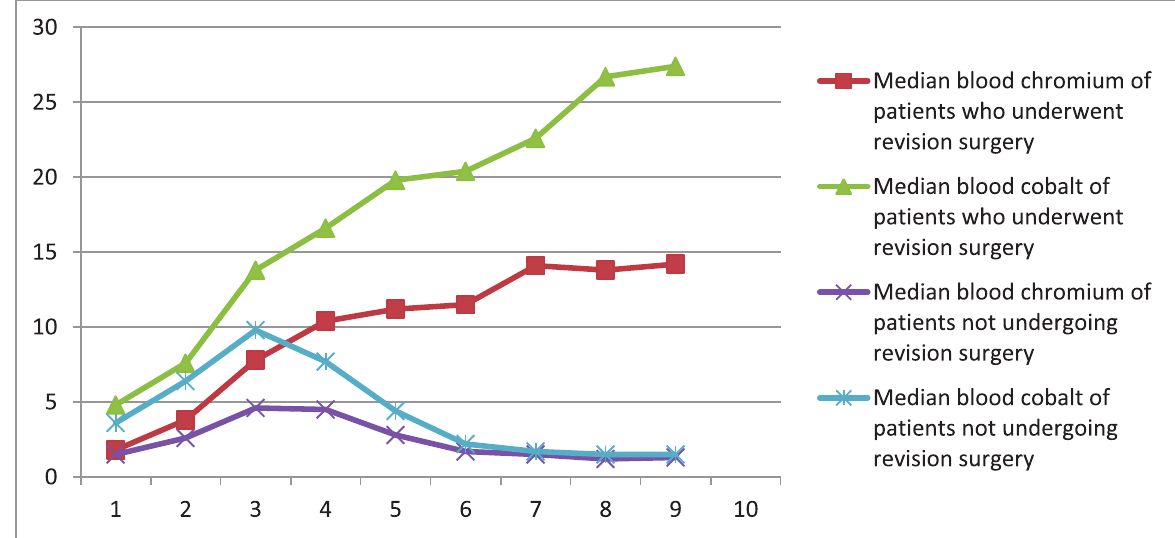
Figure 2. Median blood metal ion concentration trend.